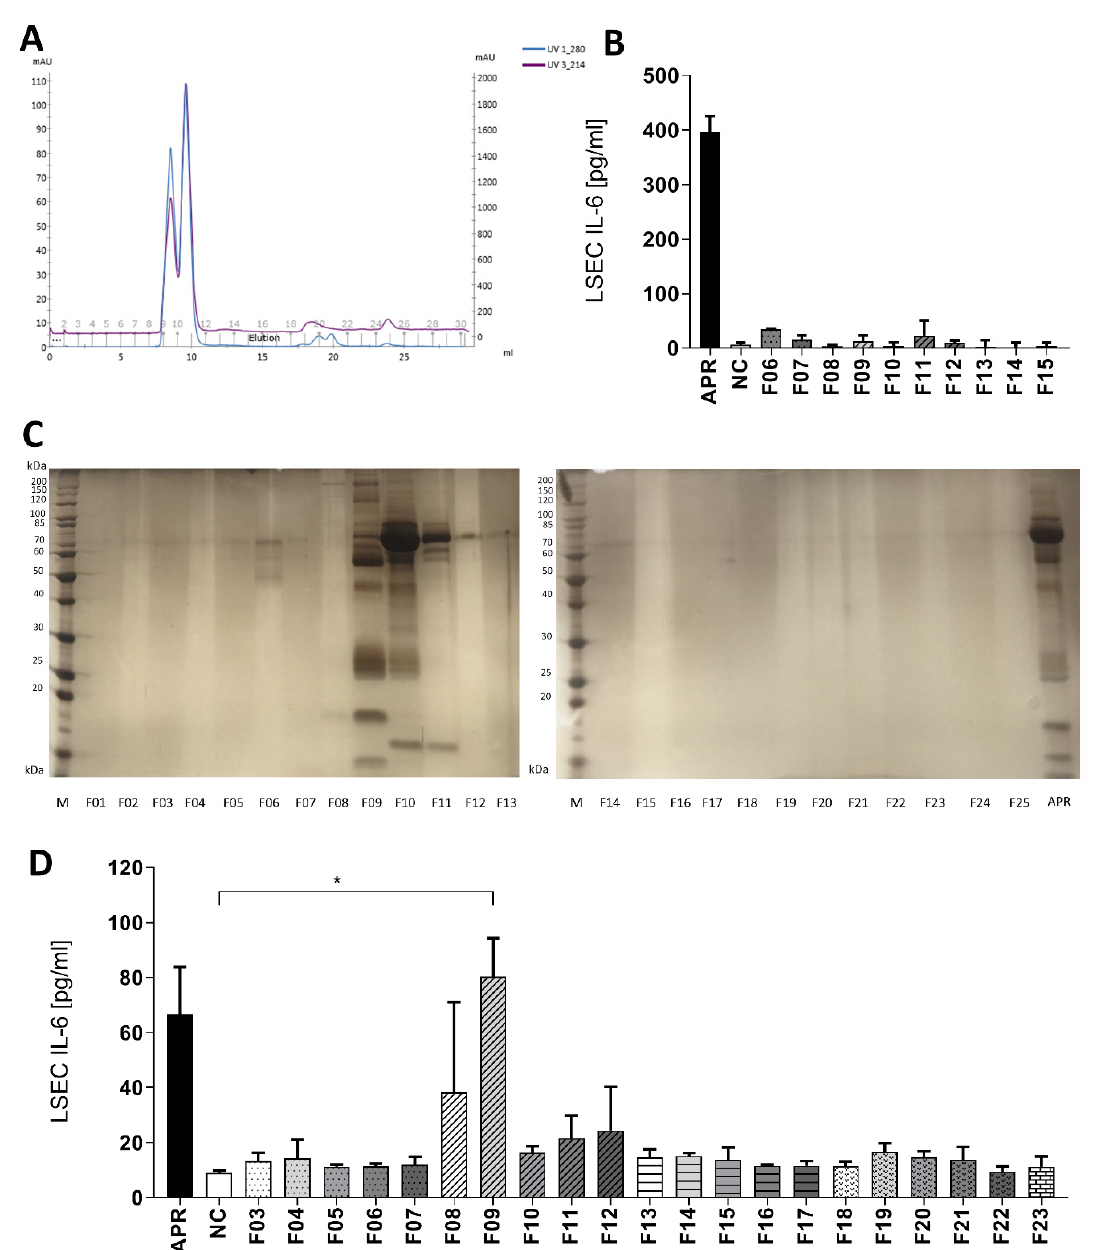
Figure 3. Gel filtration on a Superdex 75 increase column. ( A ): UV protein absorbance at 280 or 214 nm. All proteins of the sample were eluted from fraction 09 to 12. ( B ): Control experiment: eluted fractions of applied tyrode bu ff er and purified bovine thrombin were used for inducing IL-6 secretion by LSEC. Thrombin in tyrode bu ff er fractions did not activate LSEC. NC: negative control, tyrode bu ff er. ( C ): Silver-stained 12% polyacrylamide gel after SDS-PAGE showing proteins in APR fractions obtained after gel filtration. Proteins were mainly found in fractions 09 to 12. M: calibration, APR: non-fractionated APR. ( D ): Selected fractions were added to LSEC and IL-6 secretion assessed after 24 h of culture. Solely fraction 09 (F09) induced a statistically di ff erent IL-6 response compared to tyrode bu ff er, the negative control (NC), * p -value between 0.01 and 0.05 ( t -test). APR prepared from 640,000 platelets / µ L. n = 2. If not otherwise specified, presented data are representative of 2 or 3 independent experiments.